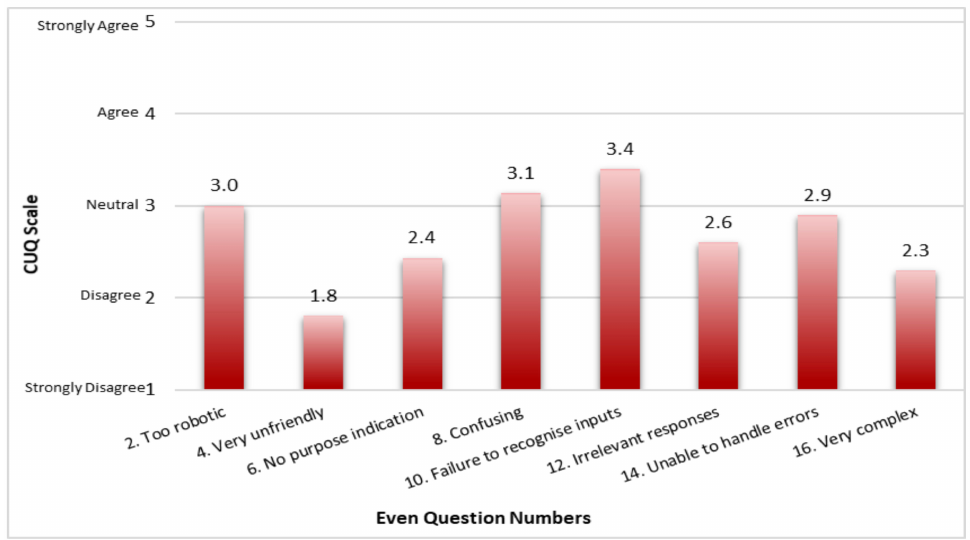
Figure 2. Average ranking for the negative aspects of MYA’s usability.